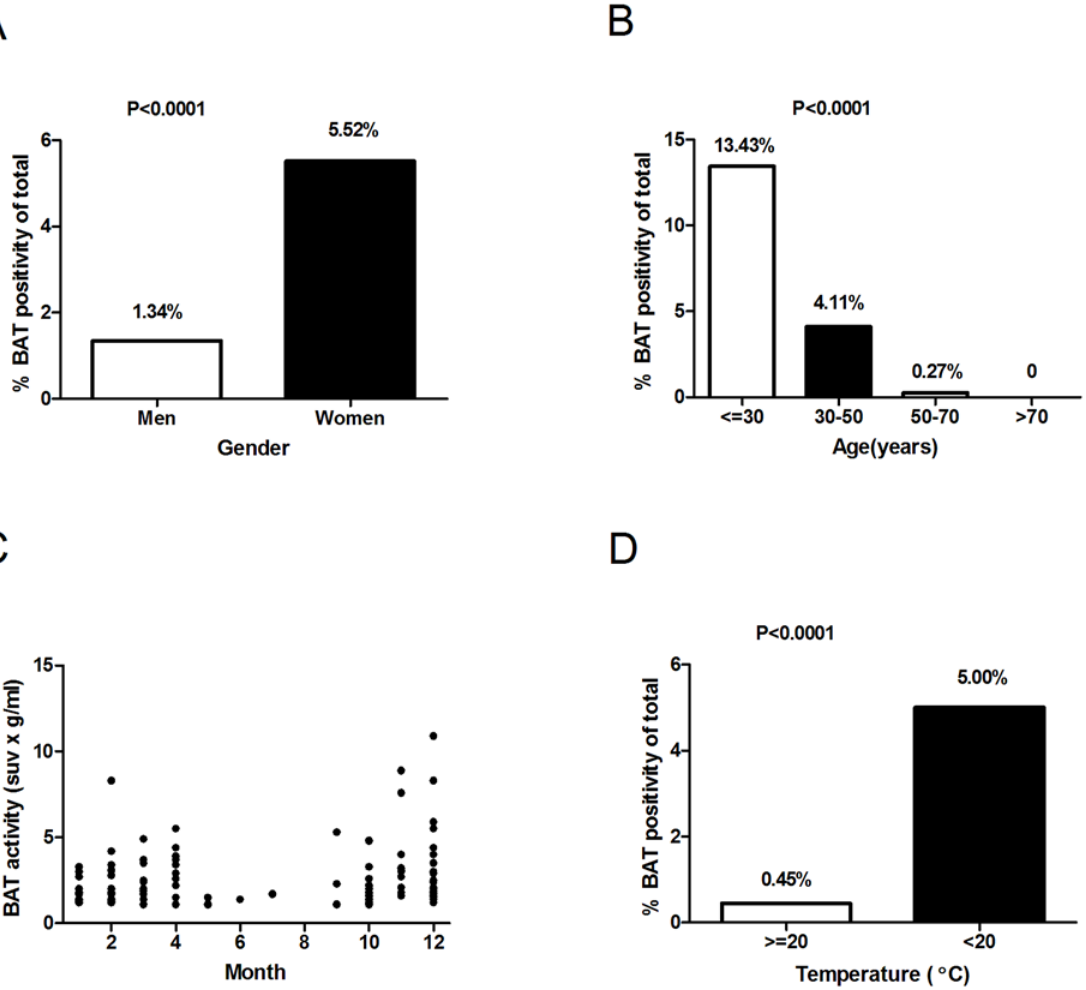
Fig 1. Correlation between the prevalence of badipose tissue and temperature, age and gender. Panel A shows the prevalence of detectable BAT in men and women. Panel B shows the percentage of patients in different age ranges that had detectable BAT. In panel C, for the patients with detectable BAT, the activity of BAT in grams times the mean standardized uptake value (SUV) in grams per milliliter was shown in each month during a 3 year period from May 2007-Feb 2010. In Panel D, outdoor temperatures in Shanghai for the dates of scans were obtained and the percentage of subjects with detectable BAT in different temperature ranges was determined. A univariate analysis was used to assess the significance of differences in the percentages with the use of a chi-square